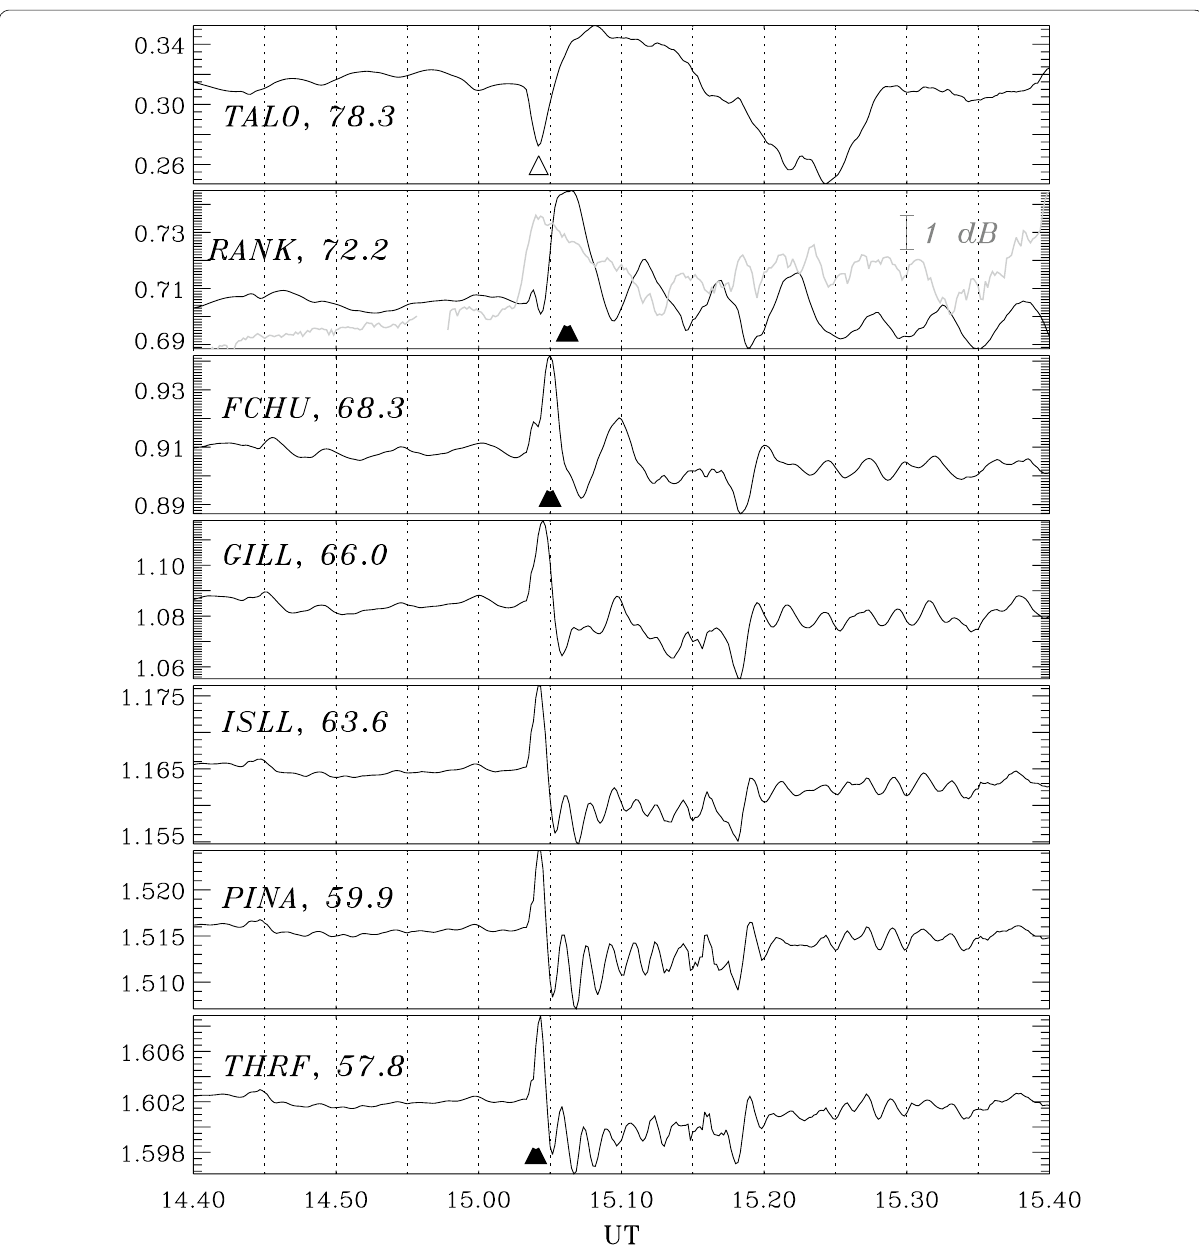
Fig. 3 The magnetograms (X-component in 10 4 nT) of the latitudinal profile of stations TALO, RANK, FCHU, GILL, ISLL, PINA, and THRF from the CARISMA array during the time period 1440–1540 UT. Geomagnetic latitudes are indicated near the station codes. Gray line shows variations of riometric absorption at RANK. The PI and MI impulses are denoted with empty and filled triangles ,